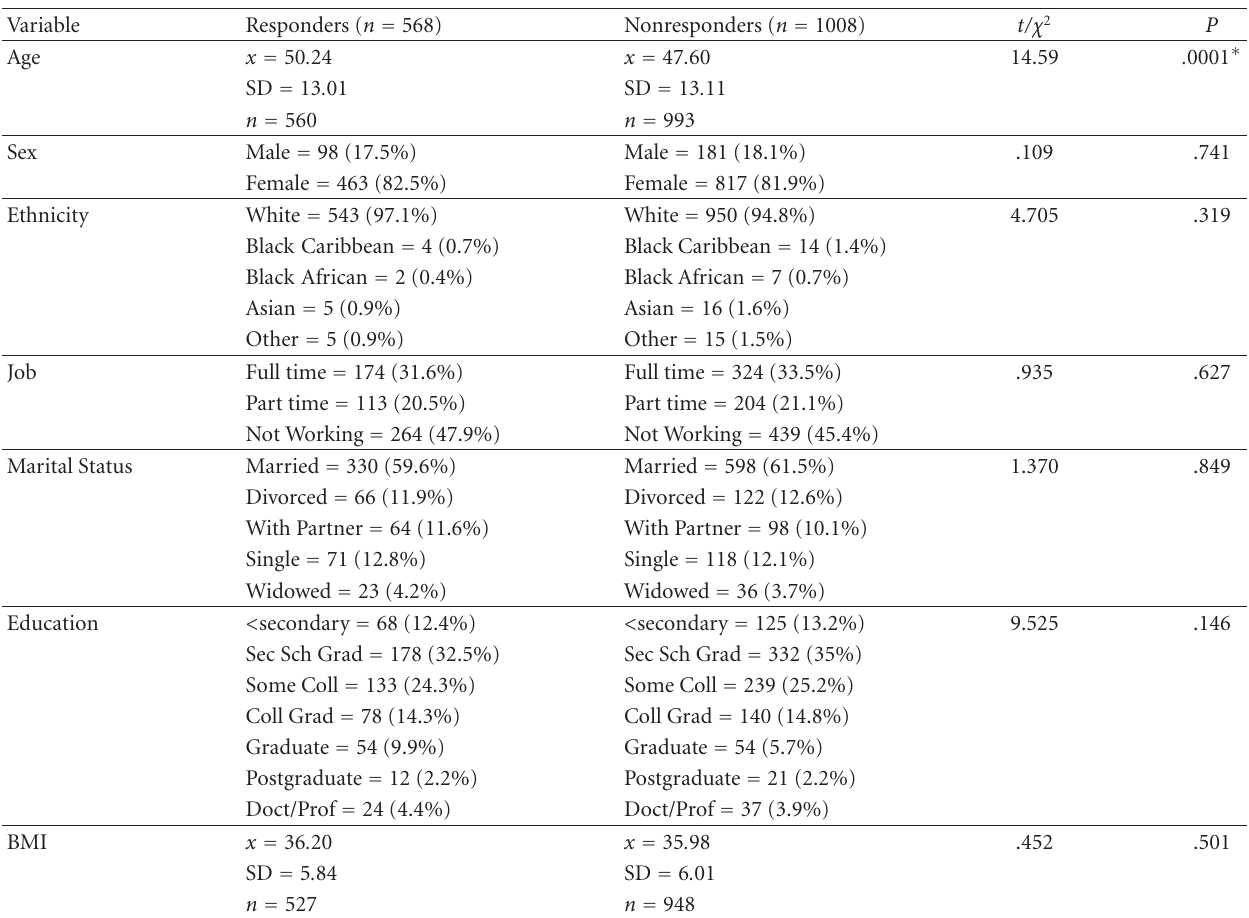
Table 1: Responders versus nonresponders at baseline.